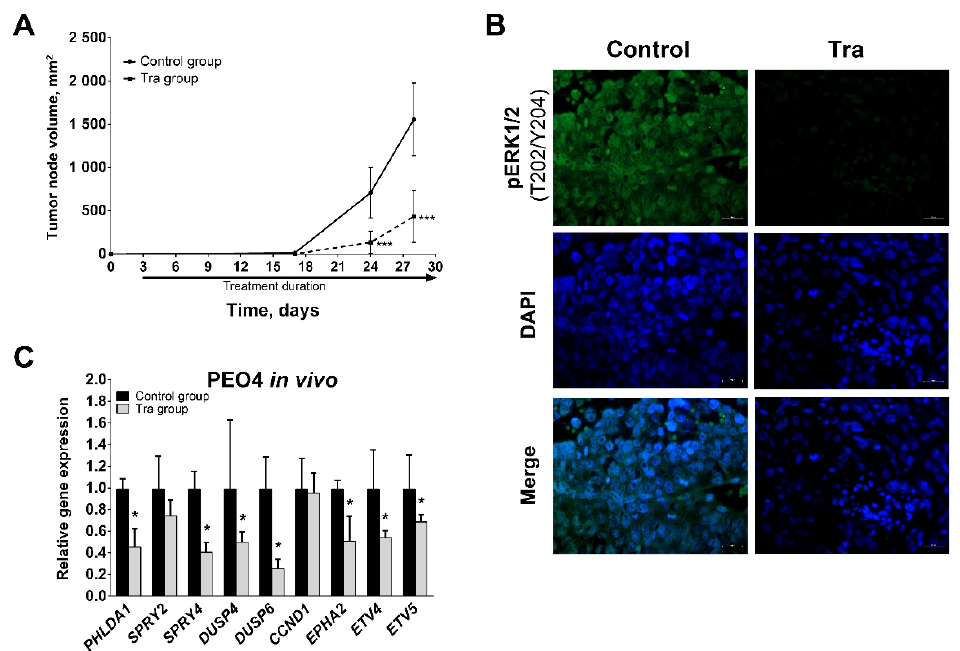
Figure 6. Effects of trametinib treatment on HGSOC growth in vivo. ( A ) Growth kinetics of tumors developed from subcutaneously injected PEO4 cells ( n = 10, Mann-Whitney U-test, *** - p < 0.001). ( B ) Immunofluorescent staining of phosphorylated ERK1/2 (green) in PEO4 xenograft tissue samples. Cell nuclei were counterstained with DAPI (blue). Scale bars: 20 μ m. ( C ) Gene expression levels of MEK1/2-responsive genes in PEO4 xenograft tissue samples. Data are normalized to “Control group” samples and presented as mean + S.D. ( n = 3, two-tailed Student’s T-test with Welch’s correction, * - p < 0.05). Tra—trametinib, pERK1/2—phosphorylated